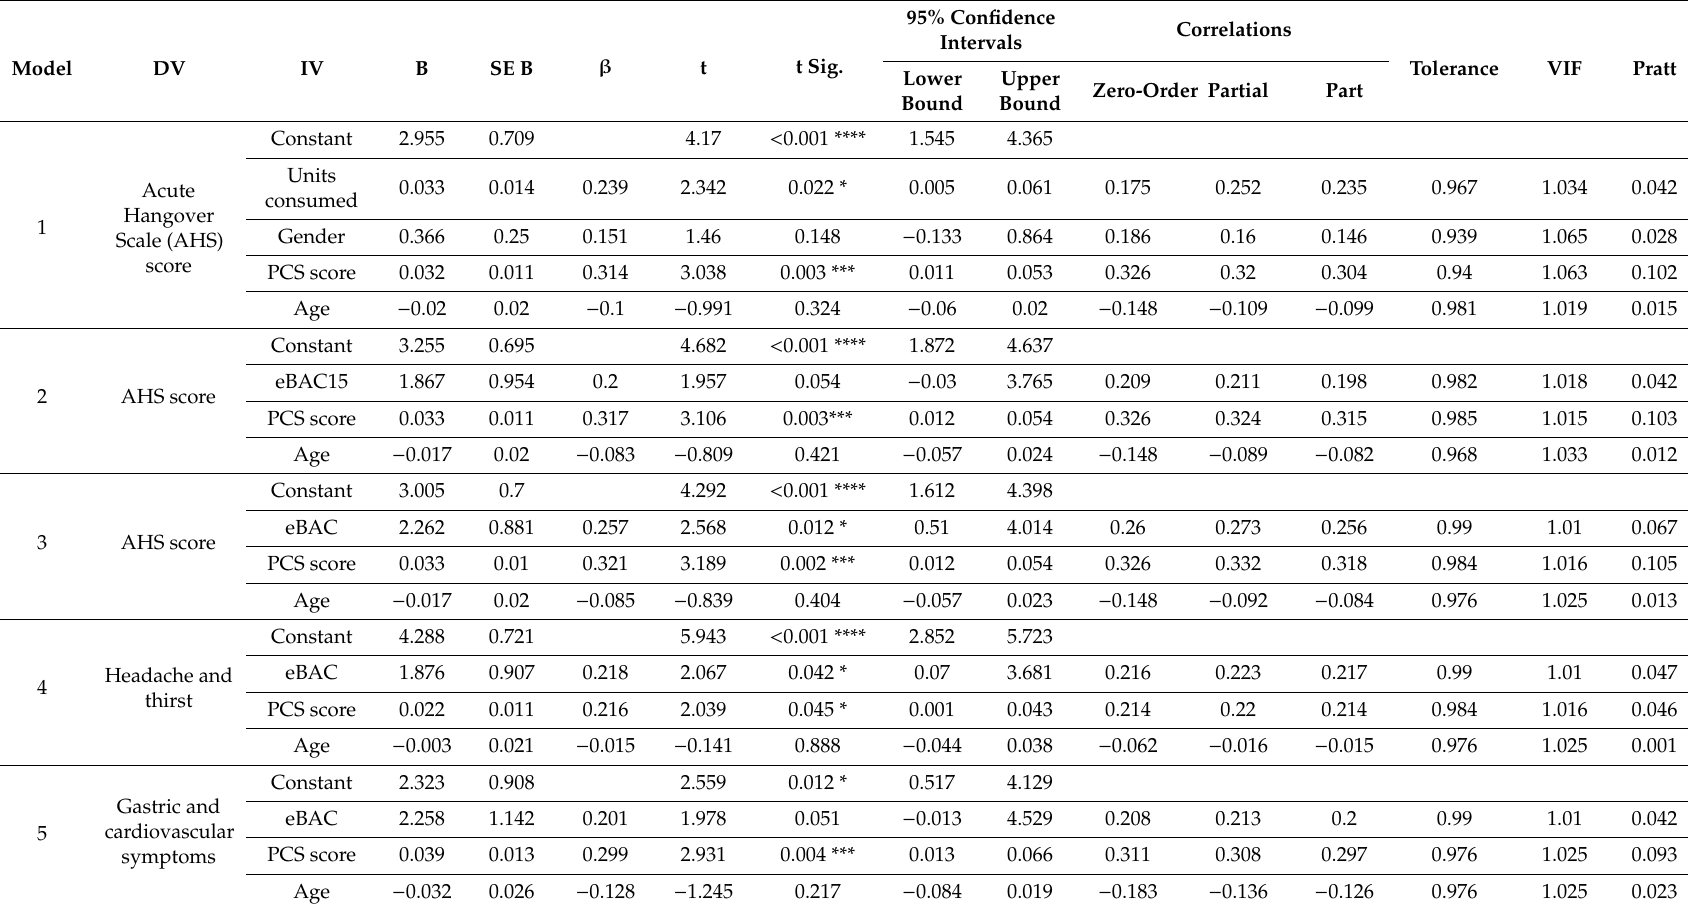
Table 6. Summary of statistics determining independent variable contributions to regression e ff